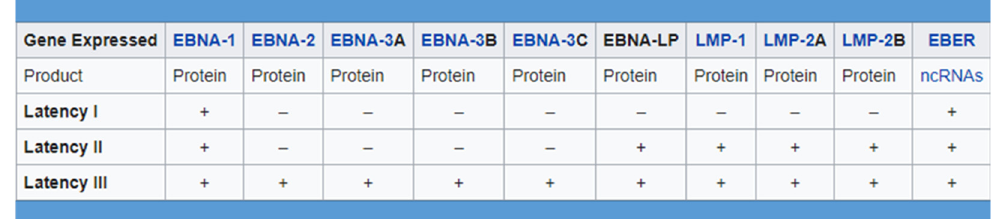
Figure 1. There are three forms of latency expressed by EBV-infected cells, each one characterized by a unique expression of EBV-associated proteins and RNAs.